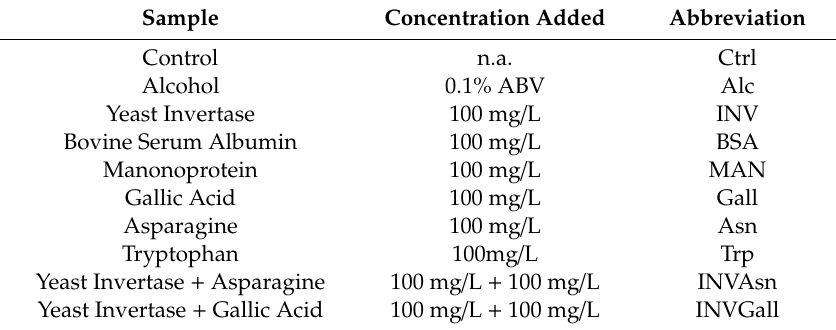
Table 1. Summary of samples, chemical additions and corresponding